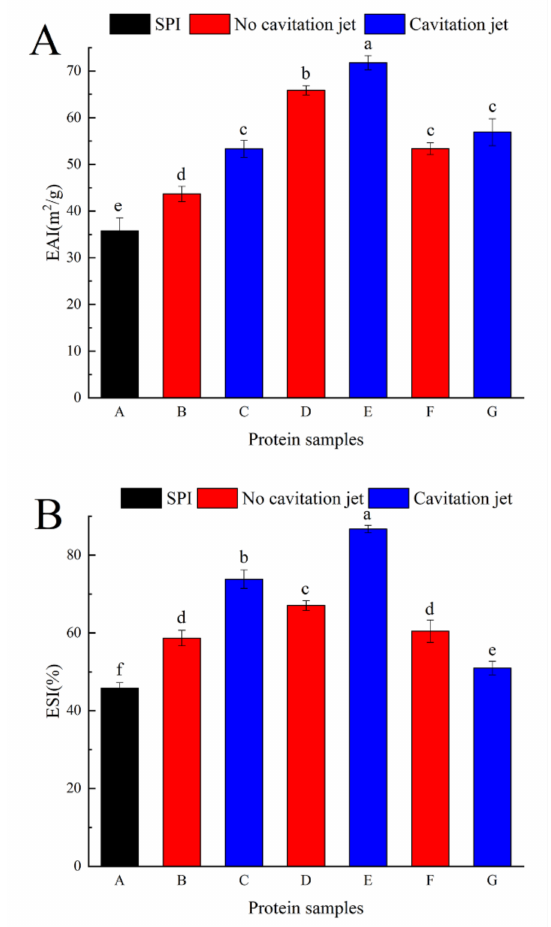
Figure 3. Emulsification activity index (EAI; A ) and emulsion stability index (ESI; B ) of SPI emulsions oxidized before and after cavitation jet treatment. Columns with different letters (a–f) are significant differences ( p <